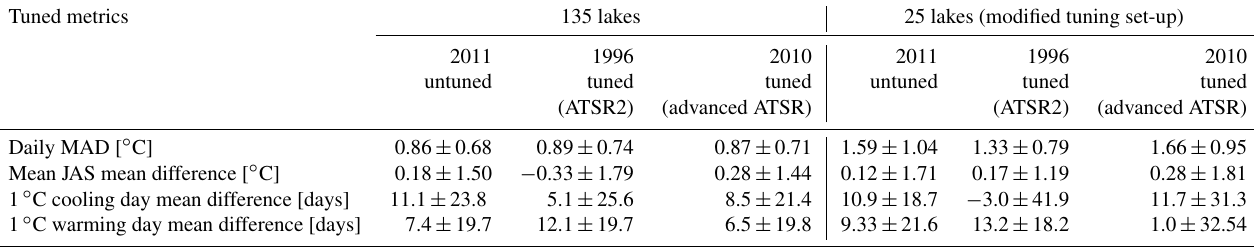
Table 10. Results of independent evaluation of the tuning process for seasonally ice-covered lakes. The spread of differences across lakes is defined as 2 σ . These results illustrate that the metrics (explained in Table 4) from the untuned year (2011) compare well with metrics from 1996 (the first full year of data from along-track scanning radiometers 2 (ATSR2)) and 2010 (the last year of tuned data from Advanced ATSR. For the untuned year (2011)) for each lake, the model is forced with the effective lake depth (Zd), snow and ice albedo ( α) and light extinction coefficient ( κ d ) values determined during the tuning process, shown in the supplement. Units are given in square brackets.